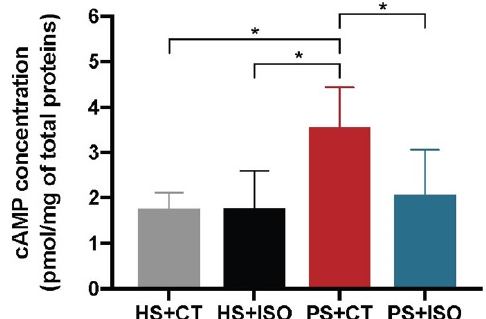
Figure 4. cAMP levels in the epidermis of healthy substitutes (HS) and psoriatic substitutes (PS) produced with either cholera toxin (+CT) or isoproterenol (+ISO). Data presented are the means +/- SD ( N = 2 donors per condition, n = 2 skin substitutes per donor). The statistical significance was determined using one-way ANOVA followed by a Tukey’s post-hoc test. (* p -value < 0.05).